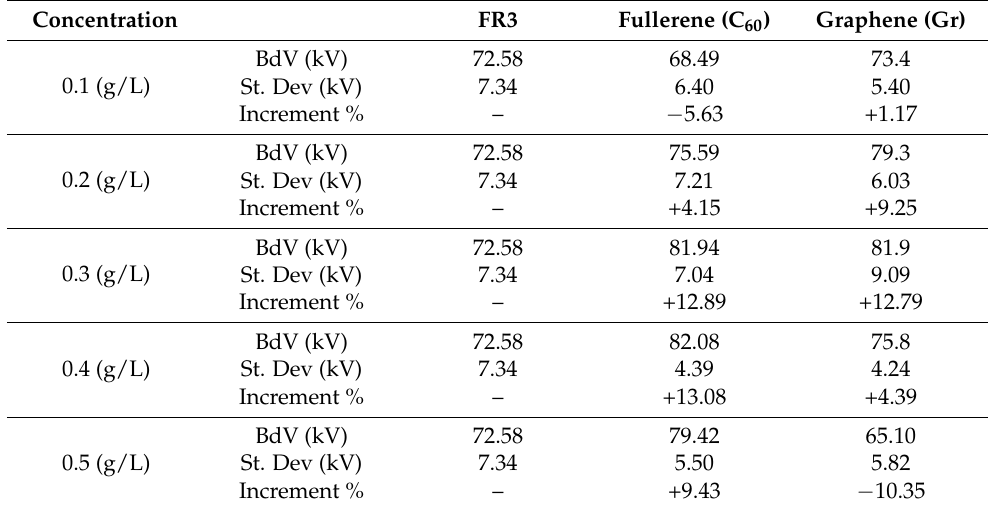
Figure 2. Mean breakdown voltages versus graphene (Gr) concentrations. Table 4. Mean breakdown voltages and standard deviation values of different nanofluids.